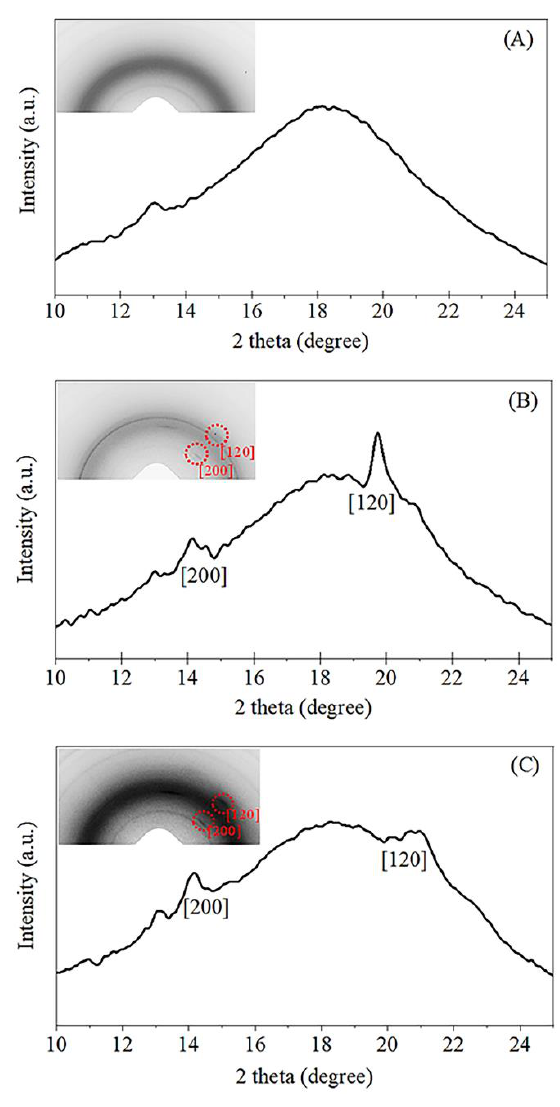
Figure 6. Coupled 2D WAXS images and WAXS patterns of ( A ) NR, ( B ) NC/NR, and ( C ) CNF/NR measured at a strain of 200%.